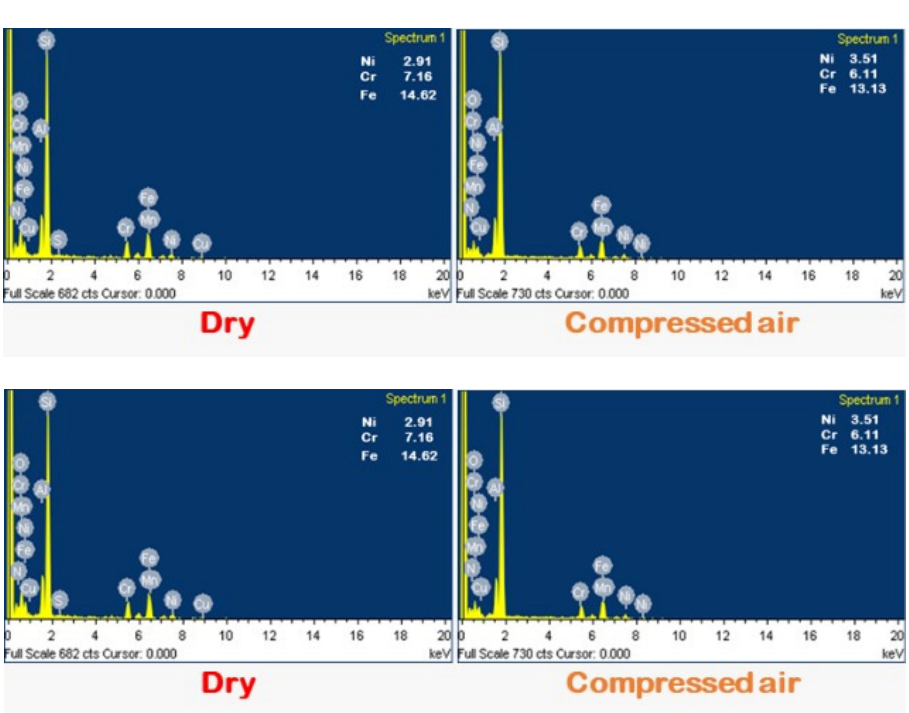
Figure 7. EDS spectrum of tool’s flank surface under various cutting environments at f = 0.24 mm/rev, v = 111 m/min. Adapted from